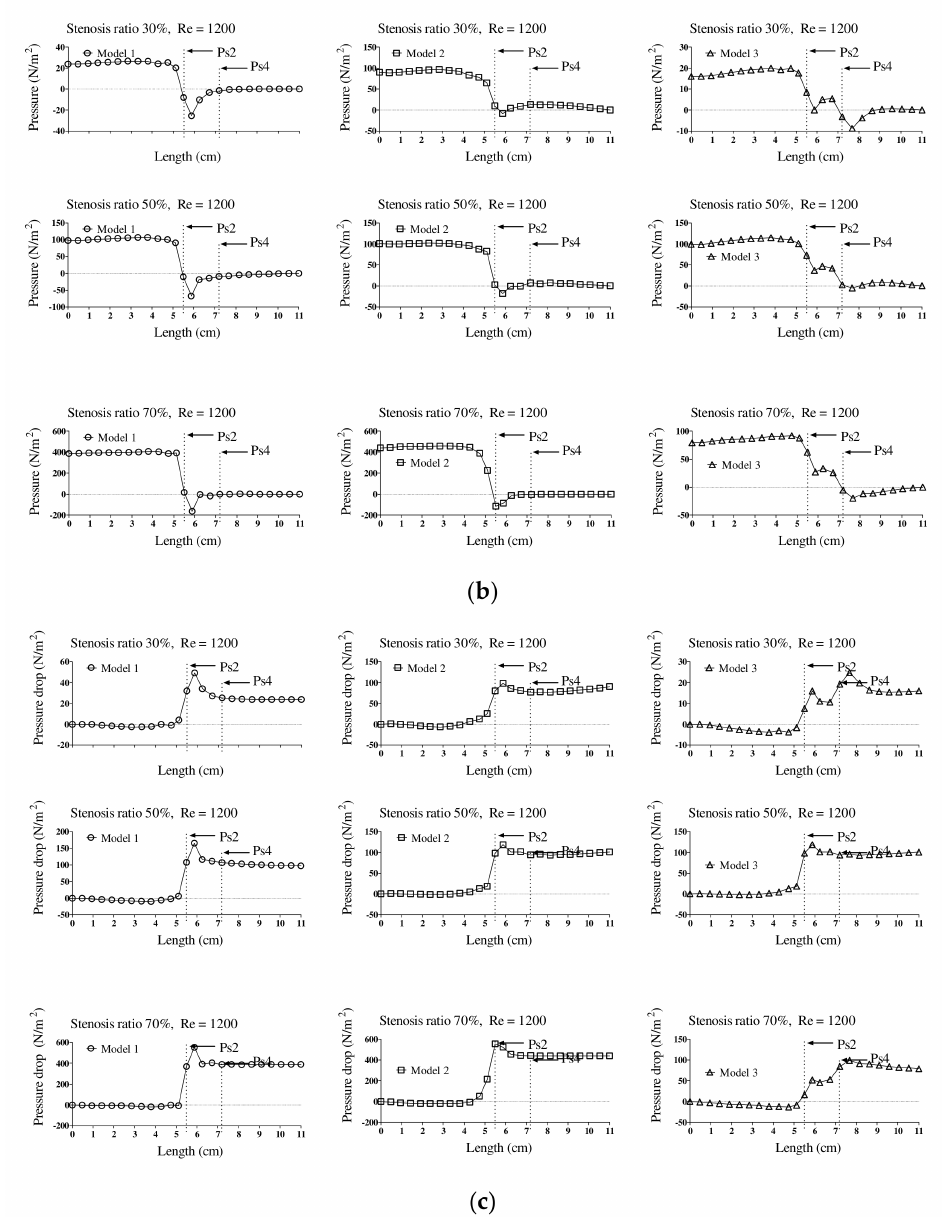
Figure 3. The pressure distribution, the average pressure, and pressure drop in the continuous flow field based on changes to the stenosis ratio at each point of the modules. ( a ) Pressure distribution, ( b ) average pressure, ( c ) pressure